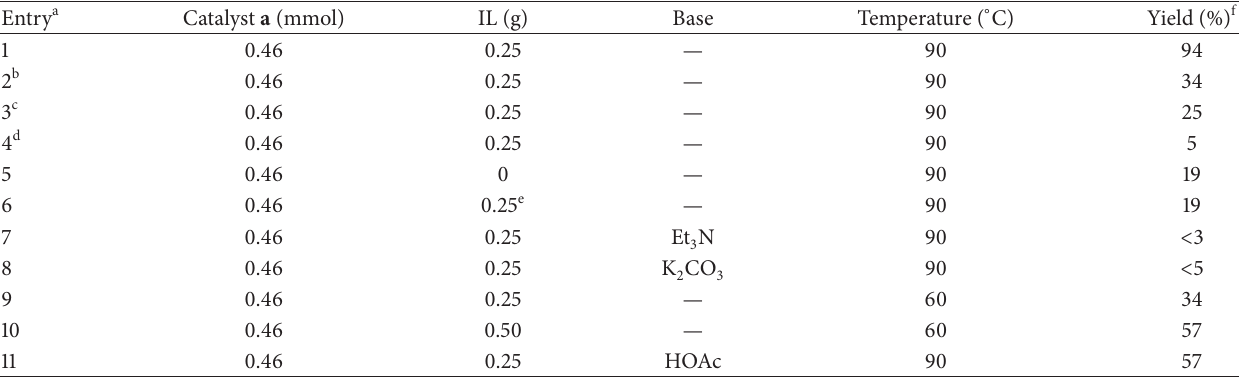
Table 1: The study of the reaction in different conditions.